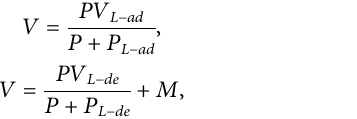
Frontiers in Earth Science |